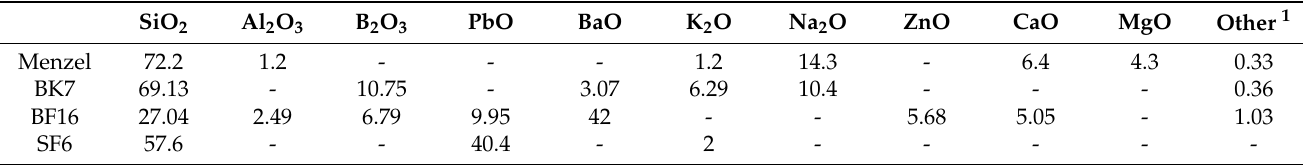
Table 3. Compositions of glasses in oxides (weight